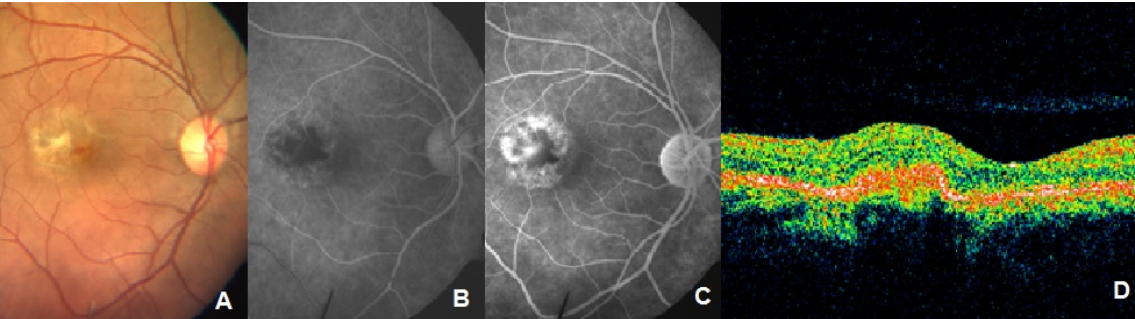
Figure 2: After PDT + IVTA. Persistent leakage from extrafoveal component, OCT shows absence of subretinal fluid.